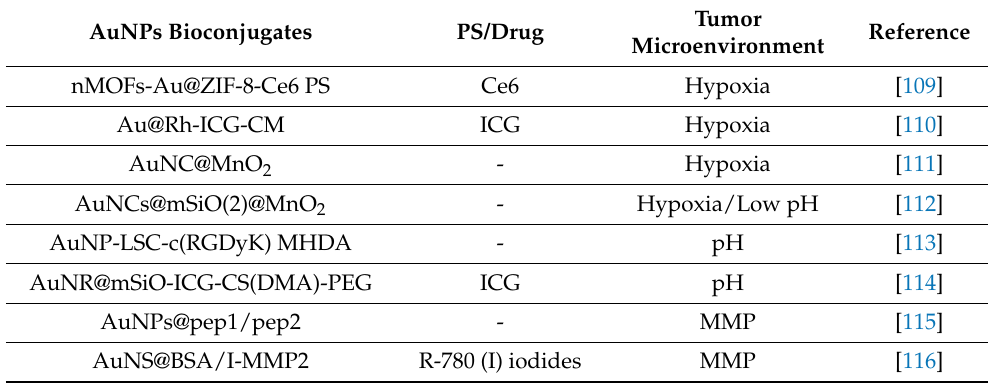
Table 5. Gold nanoparticle bioconjugates targeting the tumor microenvironment. AuNPs